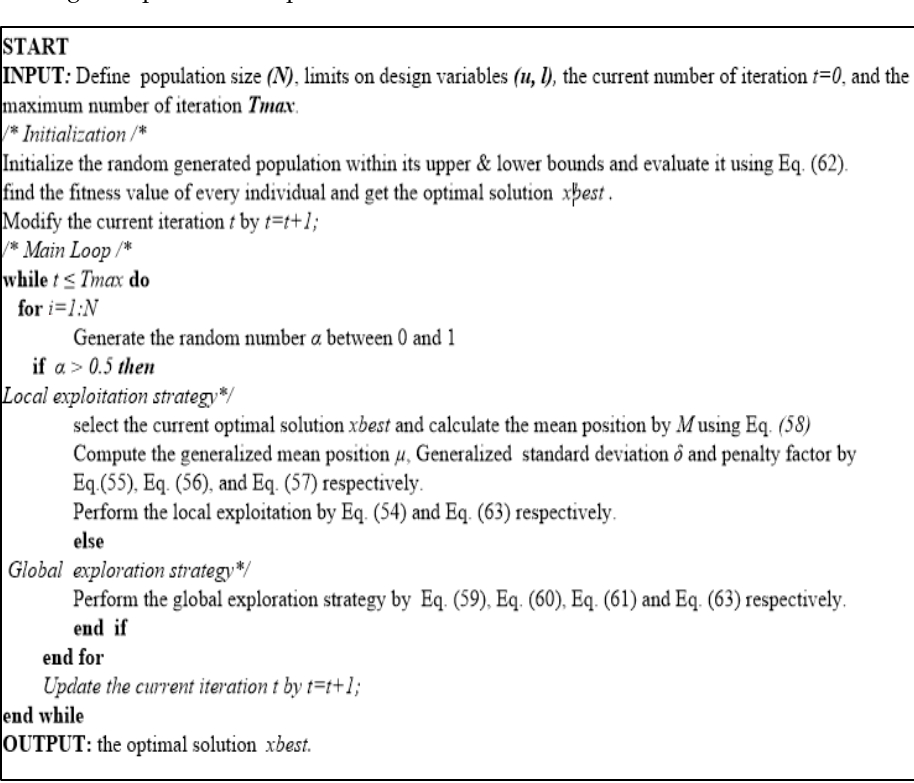
Figure 8. The pseudocode of GNDO